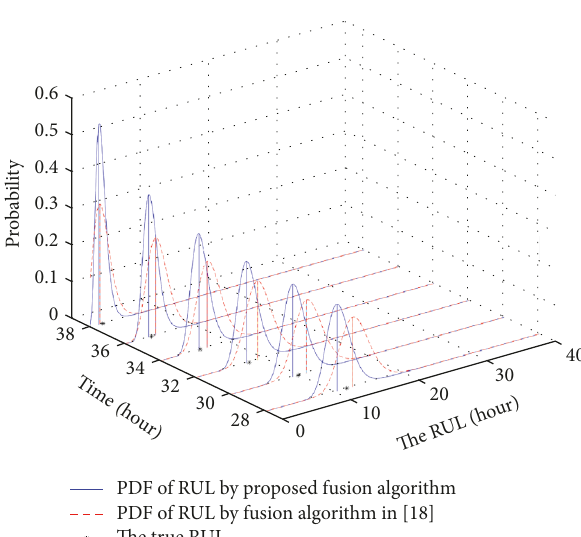
Figure 3: The PDFs of RUL at different time instants. the Probability Distribution Functions (PDFs) of RUL at